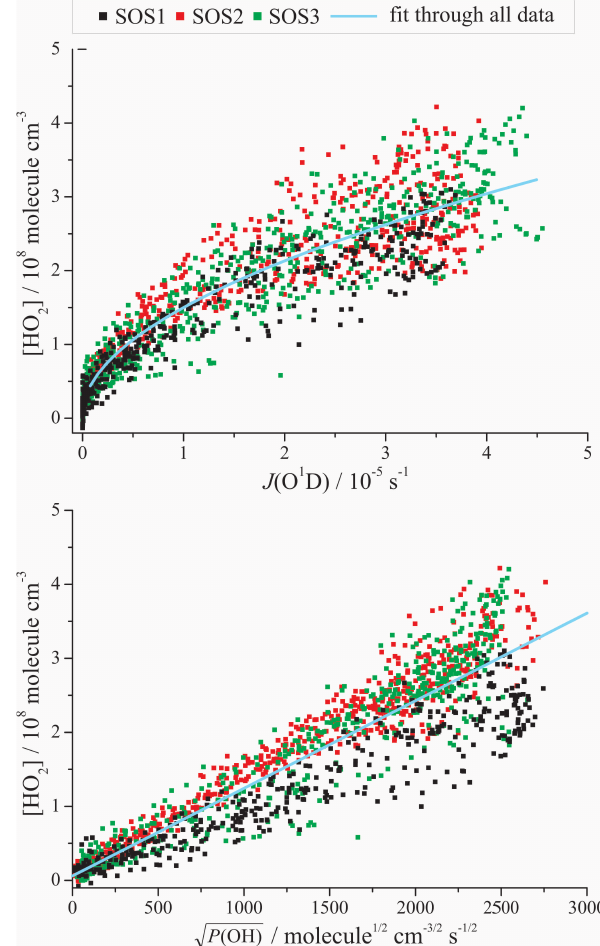
Fig. 8. Plots of four-minute averaged [HO 2 ] as a function of J (O 1 D) (upper) and P (OH) (lower). Data from SOS1–3 are rep- resented by black, red and green squares, respectively, and the blue lines are the results of the non-linear fits to the complete